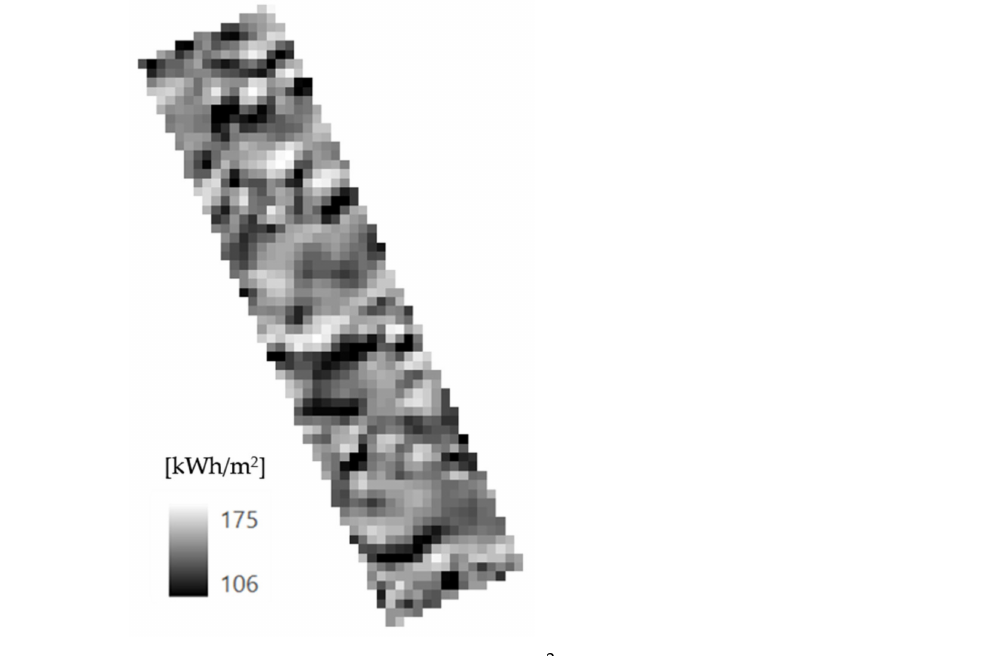
Figure 16. Solar potential values (kWh/m 2 ) obtained for the Rondo ONZ 04 bus shelter, calculated for 10:30 A.M. on 22 June